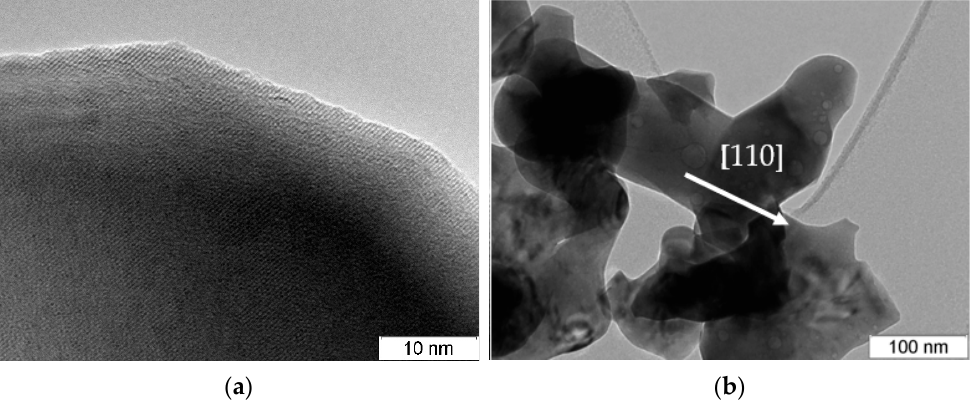
Figure 2. HRTEM images of the morphology ( a ) and crystal lattice ( b ) of the LaMn 0.8 Fe 0.2 O 3 sample.